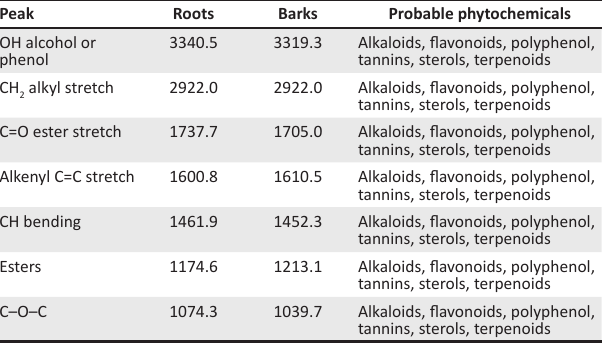
TABLE 2: Major band observed in Fourier transform infrared spectra of Prosopis juliflora